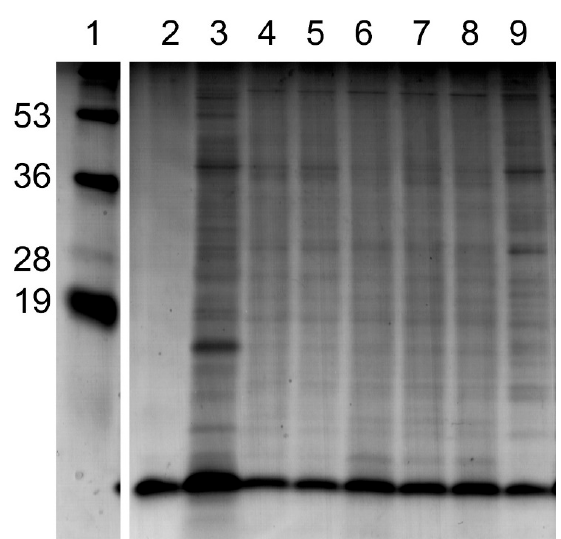
Figure 2. SDS-PAGE analysis of SV preparations. The lanes represent: 1, molecular weight standard (numbers on left in kD); 2, purified LOS isolated from F62 ∆ lgtD; 3, whole cell lysate pellet of